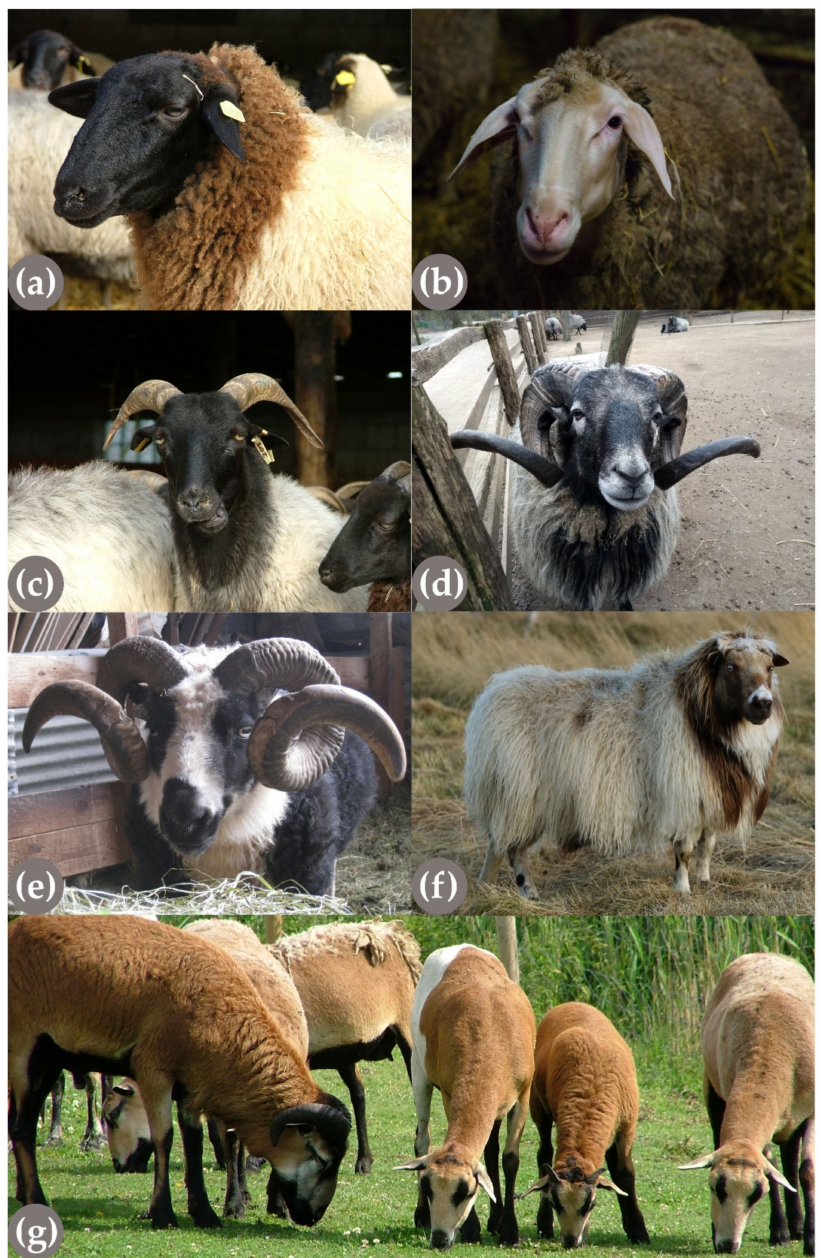
Figure 6. Sheep breeds ( Ovis aries ) showing different horn phenotypes belonging to different horn groups. Rhone Sheep ( a ) and Merinoland Sheep ( b ) (C. Barth) are typical representatives of the group of completely polled breeds. On the contrary, in breeds in which horns are fixed, both individuals develop horns, exemplified by a ewe ( c ) and a ram ( d ) of the German Grey Heath sheep breed. As an example of a breed in which horn status is variable in both sexes, two Icelandic sheep rams, horned ( e ) and hornless ( f ), are shown (K. El í sabetard ó ttir). In other breeds, the horn status is linked to the sex. For example, in the Cameroon sheep ( g ), the rams are always horned (ram on the left side and male lamb in the middle) and the females are always hornless (ewe in the middle and on the left side of the picture). Please note that a list of sheep breeds belonging to different horn status groups can be found in Table